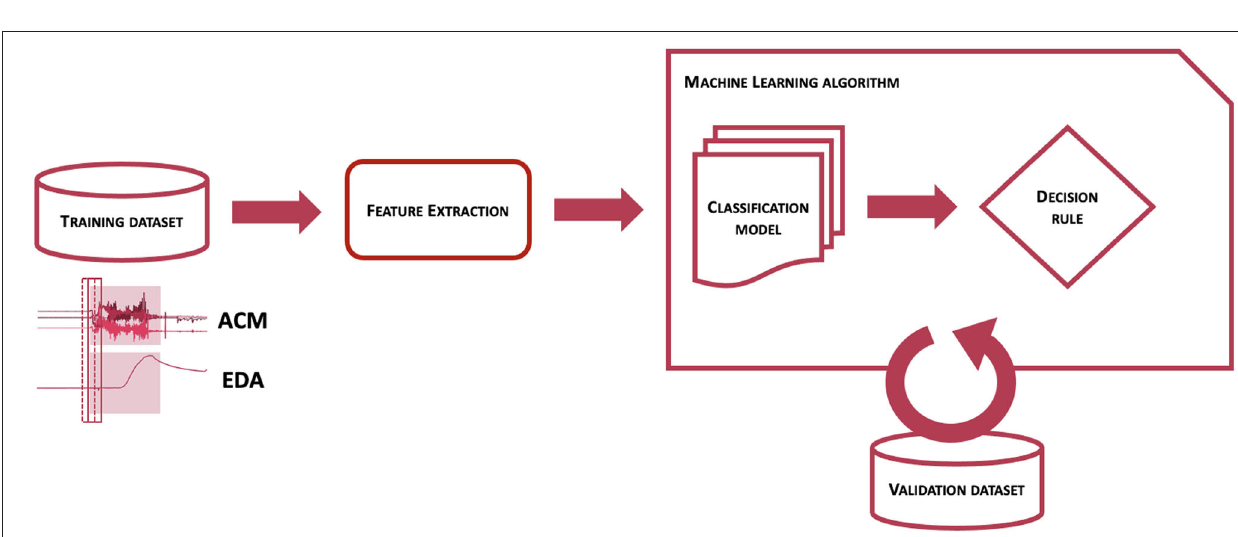
FIGURE 2 | Description of the training phase of the Detection